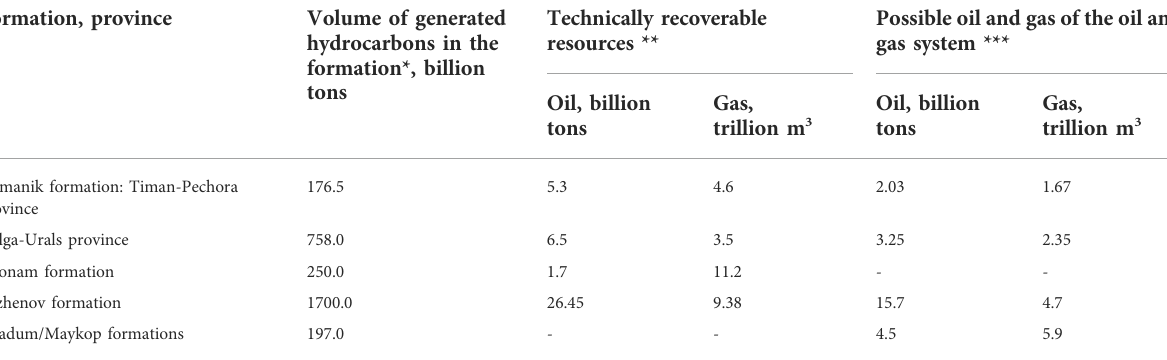
TABLE 6 Comparison of estimations of hydrocarbon resources of shale mother formations in Russia [after (Bazhenova, 1994; Bazhenova et al., 2008; Bazhenova and Dakhnova, 2014)* (Prischepa et al., 2014; Prischepa and Averyanova, 2017)** (Ahlbrandt et al., 2005)***]. Formation, province